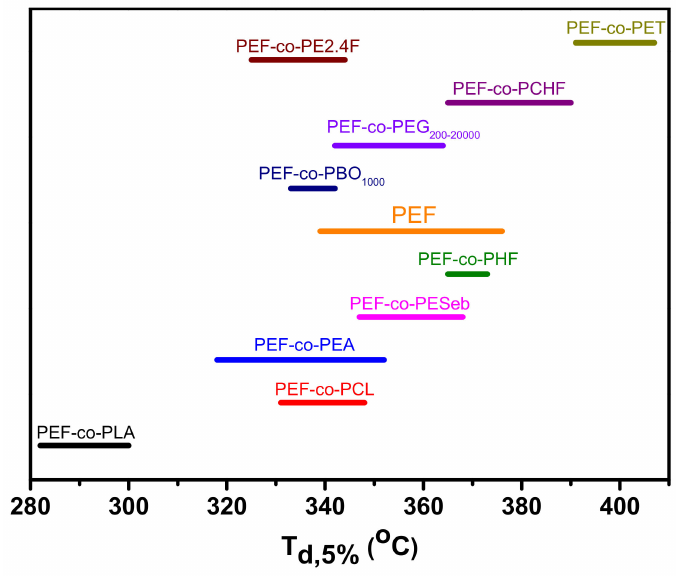
Figure 10. Thermal stability of PEF-based copolymers